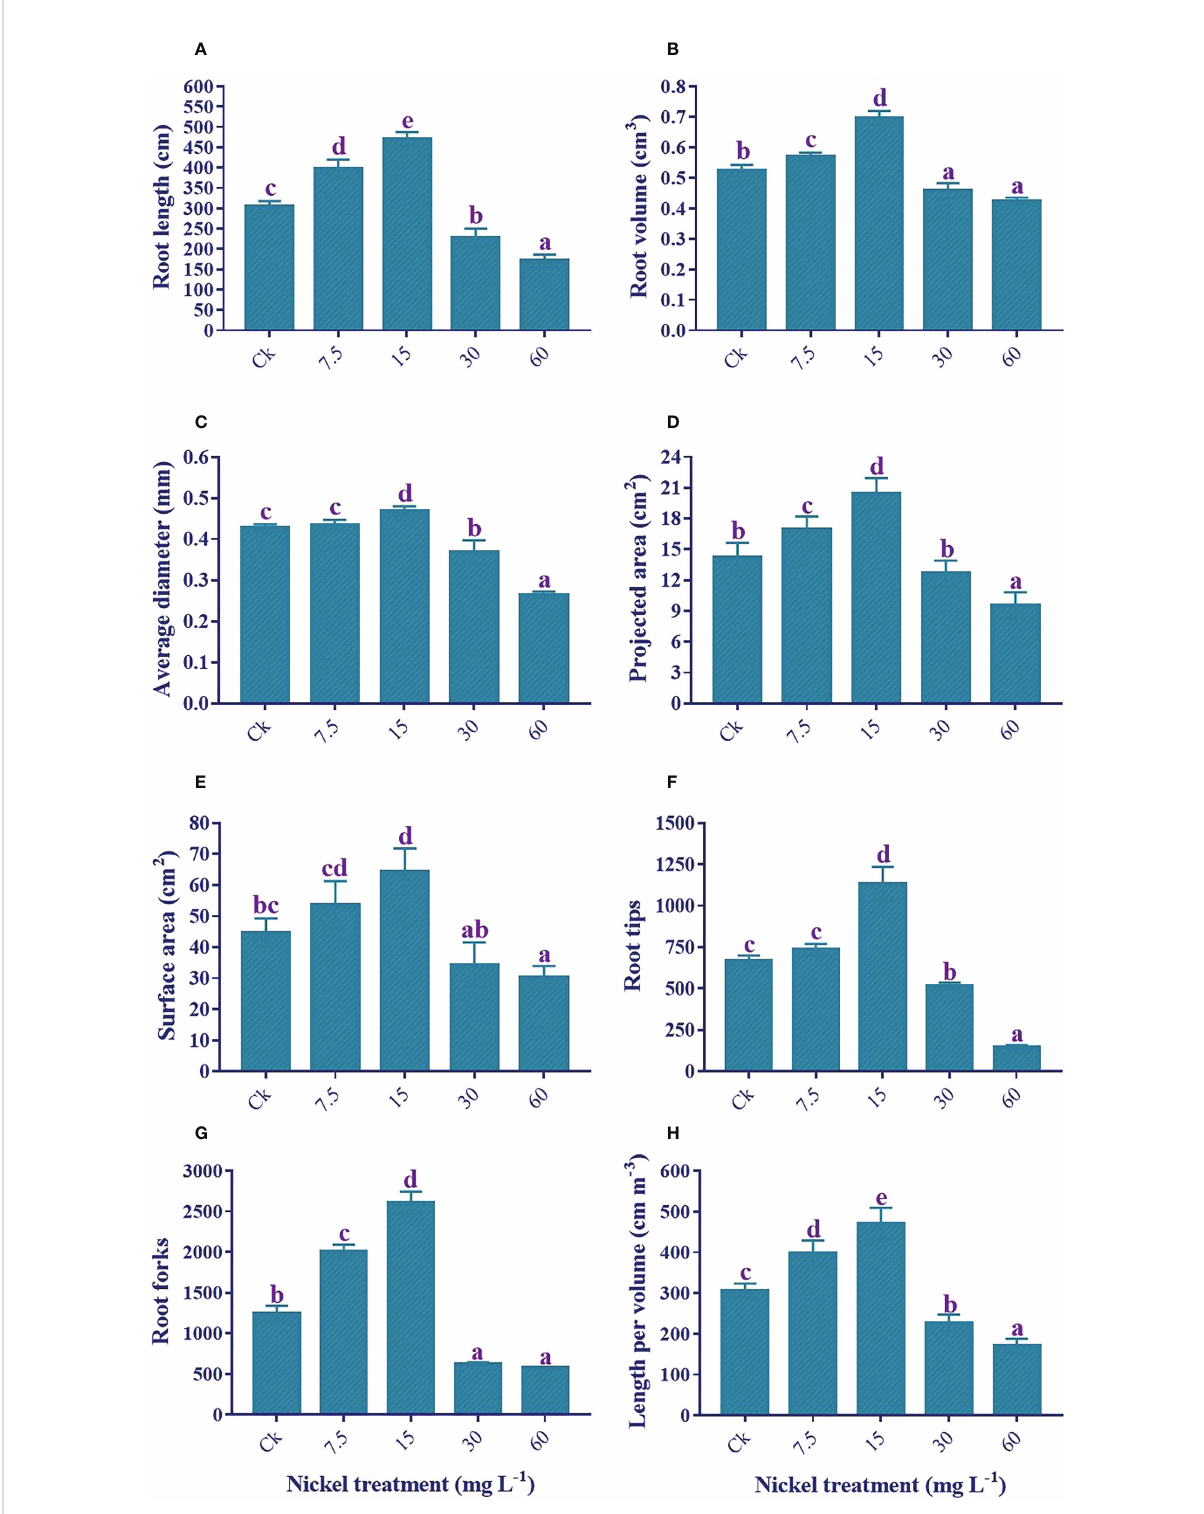
FIGURE 3 Effect of different Ni treatments on root morphology of sweetpotato; (A) root length, (B) root volume, (C) surface area, (D) average diameter, (E) projected area, (F) root tips, (G) root forks, and (H) root length per volume. According to the Duncan test, different letters indicate a signi fi cant difference ( p < 0.05) among the fi ve treatments. The error bars represent the mean ±